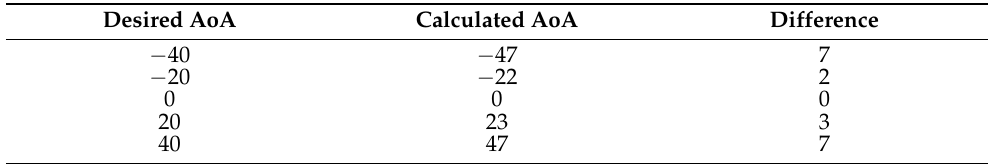
Table 3. Difference between the actual (desired) angle and the angle extracted using the beam scanner shown in Figure 7.